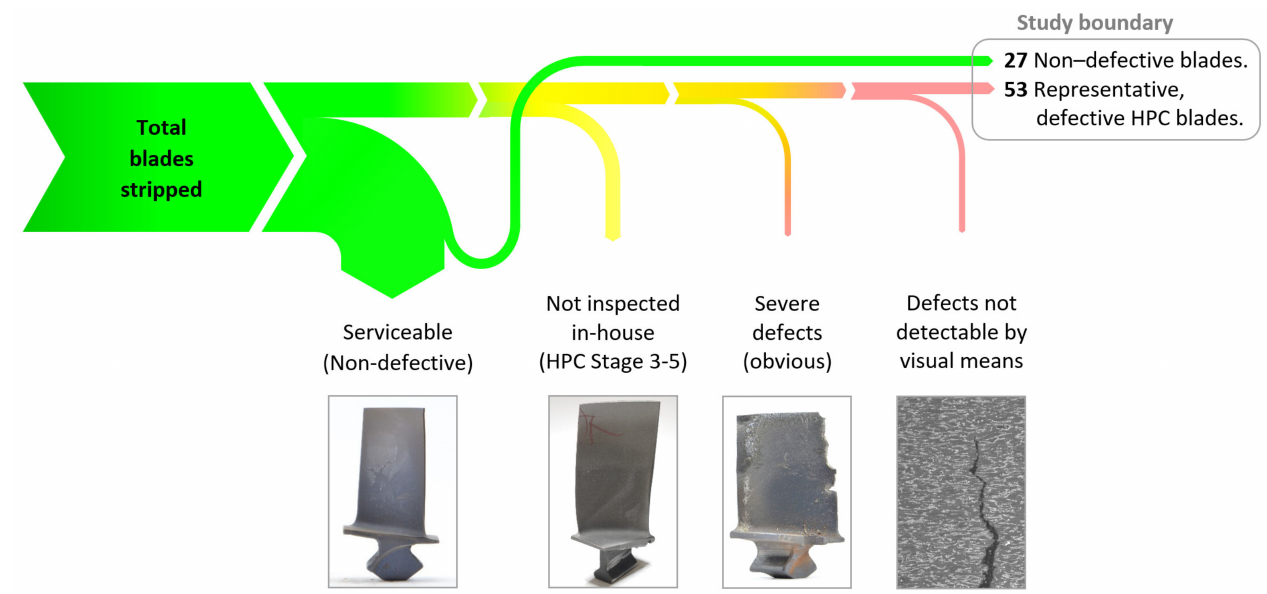
Figure 1. Sample part selection process. The diagram purely serves illustration purposes and is not drawn to scale.